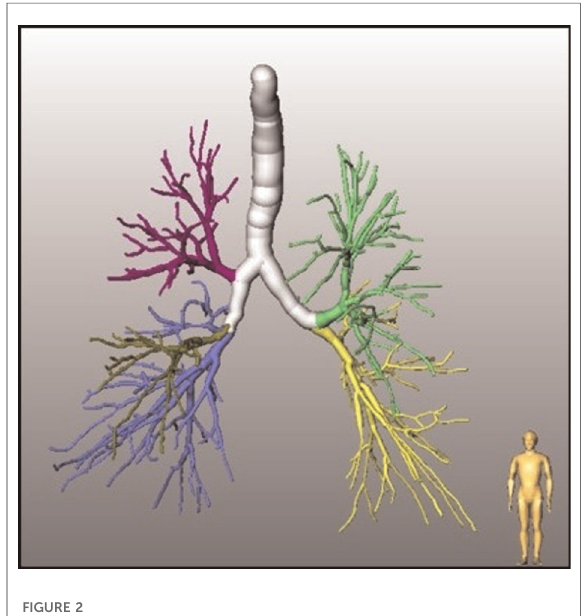
FIGURE 2 Bronchial tree with automatically identi fi ed lobe bronchi.